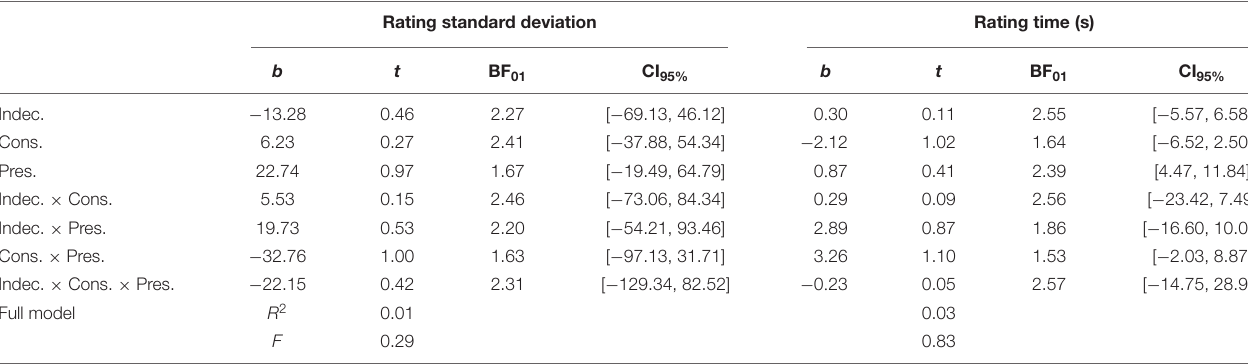
FIGURE 2 | Example of a rating trial in the sequential rating condition (top) and the simultaneous rating condition (bottom) in Study 2b. Pictures of each chocolate flavor could be dragged and dropped onto the rating scale individually. TABLE 2 | Regression of evaluation difficulty (rating standard deviation and rating time) on indecisiveness, consequence of ratings, presentation, and their interactions in Study 2b. Rating standard deviation Rating time